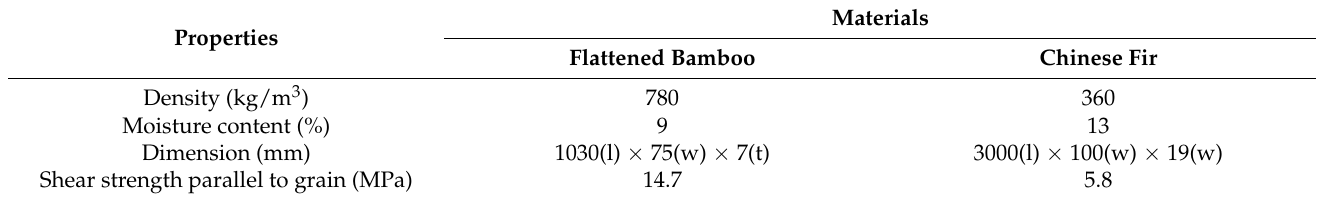
Table 1. Physical and mechanical properties of flattened bamboo boards and Chinese fir lumber.